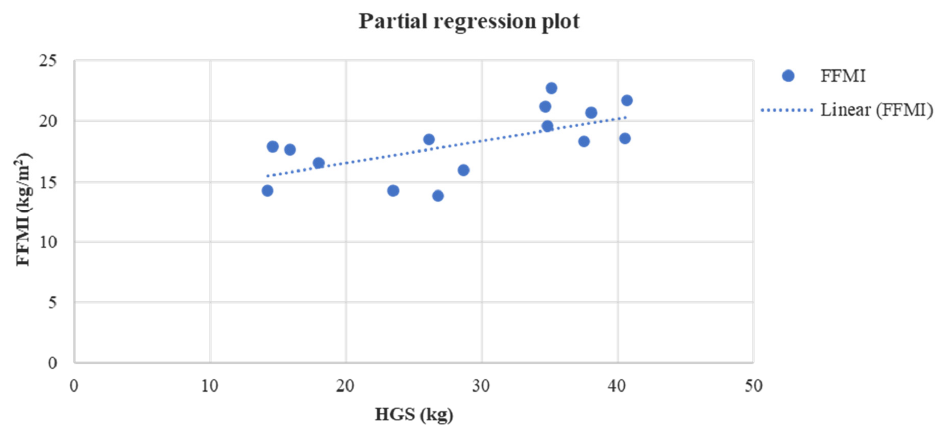
Figure 4. Linear regression analysis between the FFMI (kg/m 2 ) and HGS (kg) after four months in group A ( r = 0.64, p = 0.01).